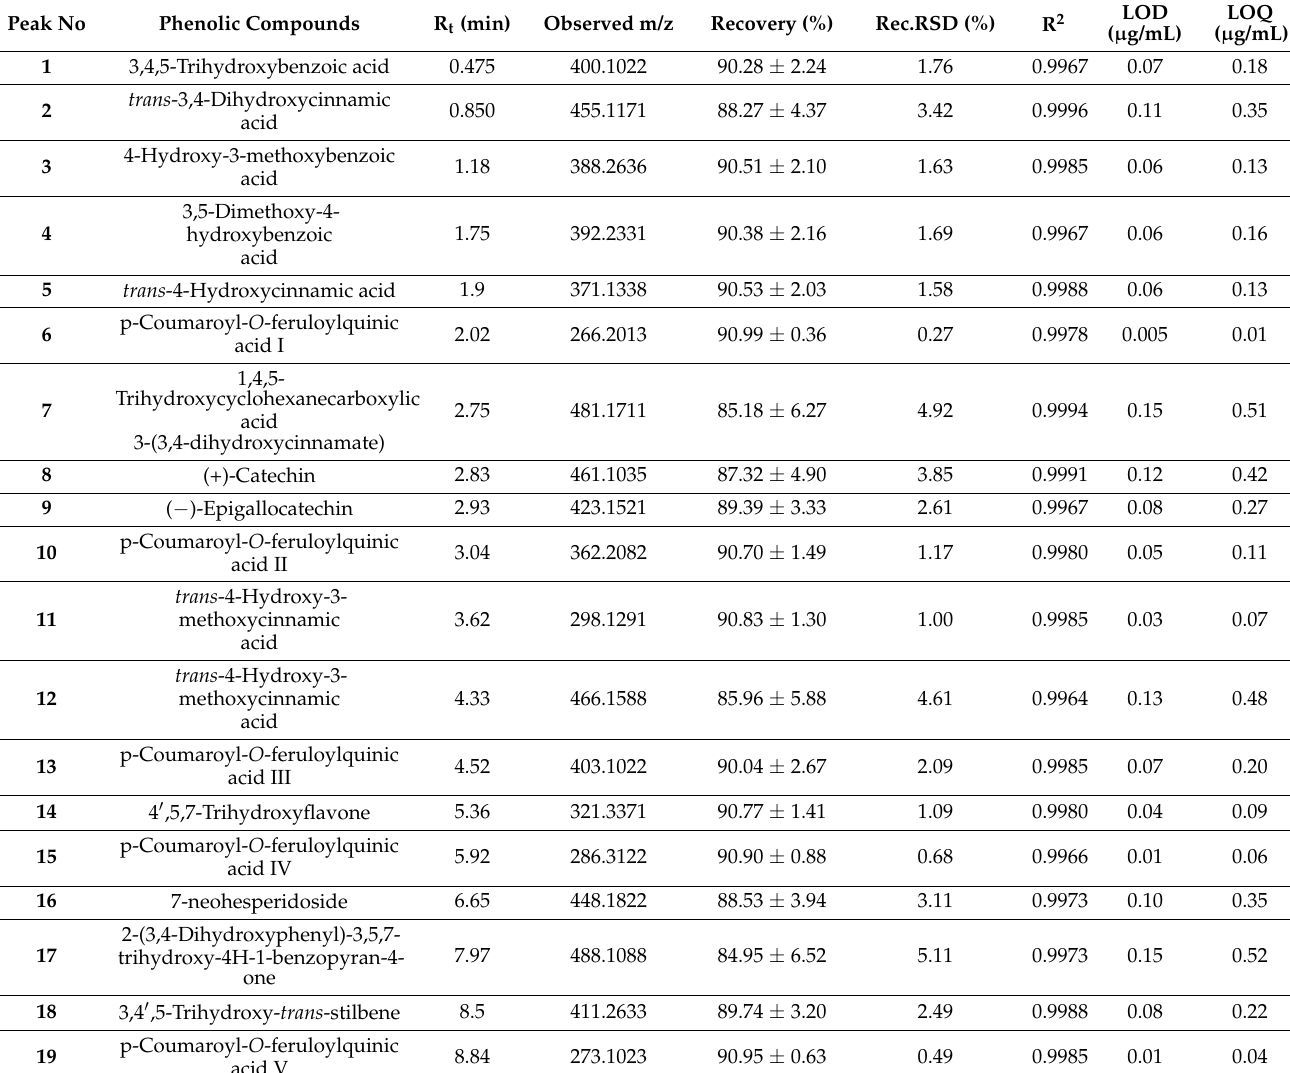
Table 2. Method calibration and validation parameters for analysis of the phenolic